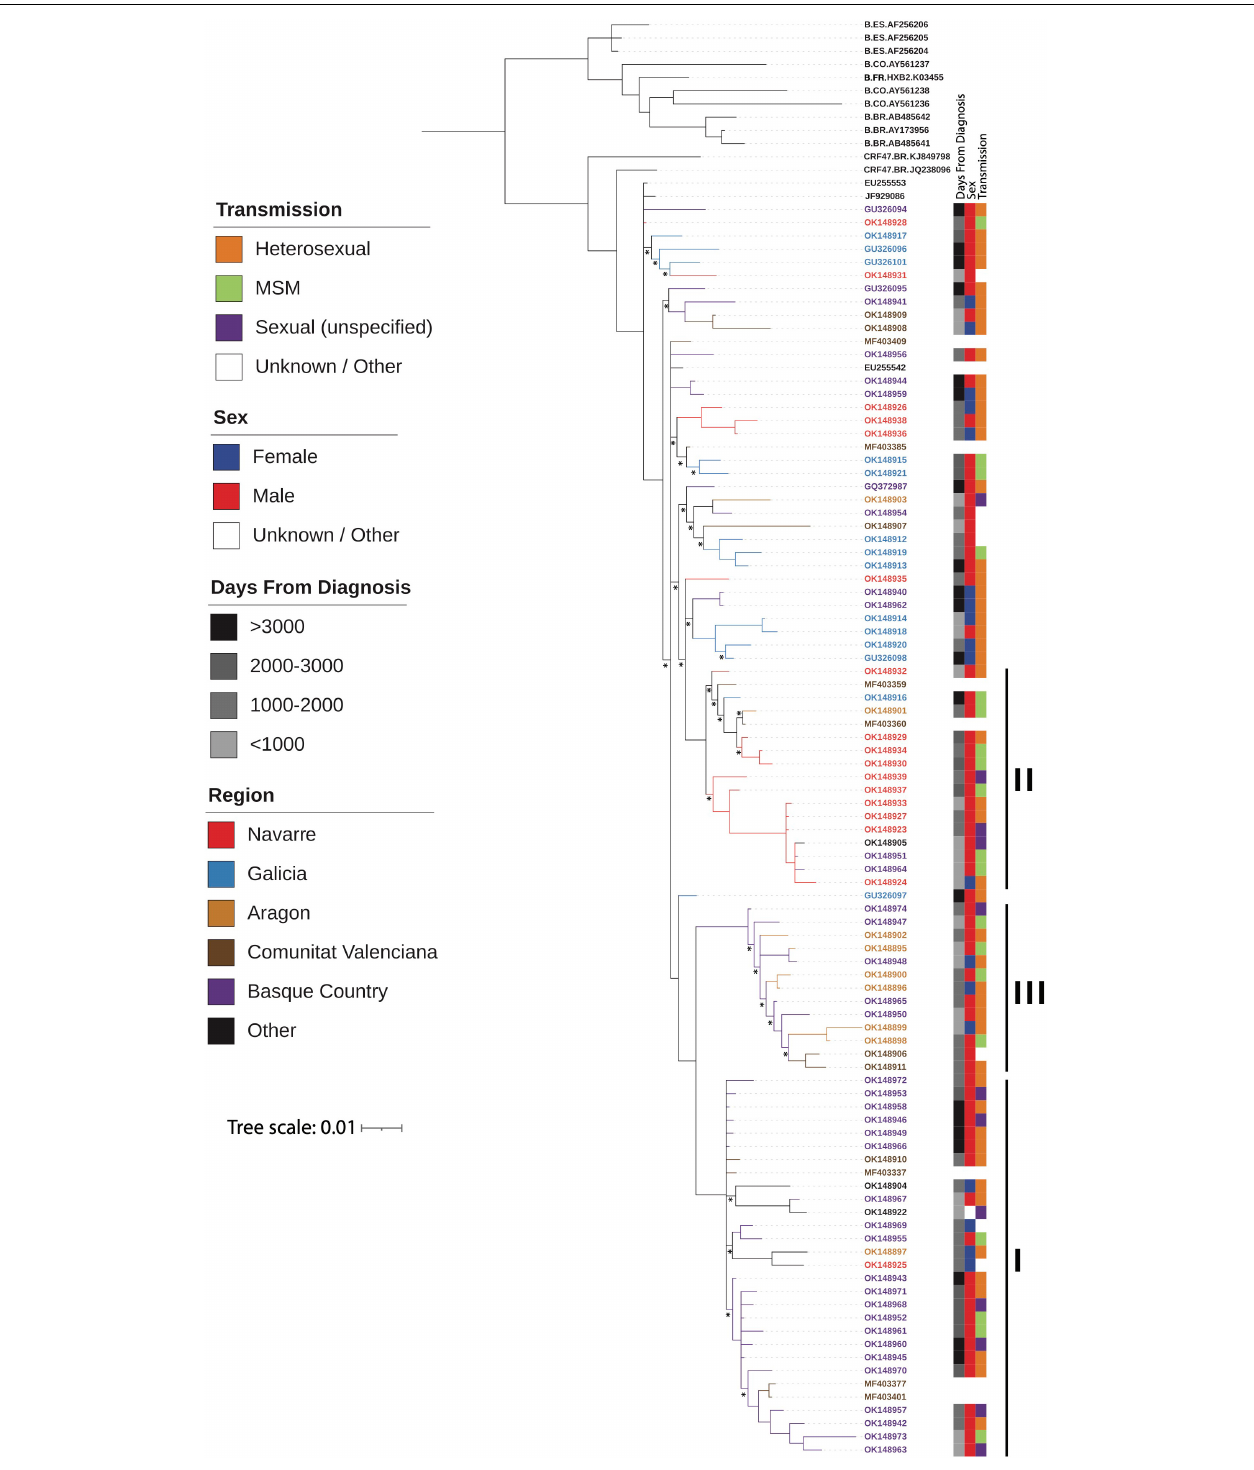
Frontiers in Microbiology |